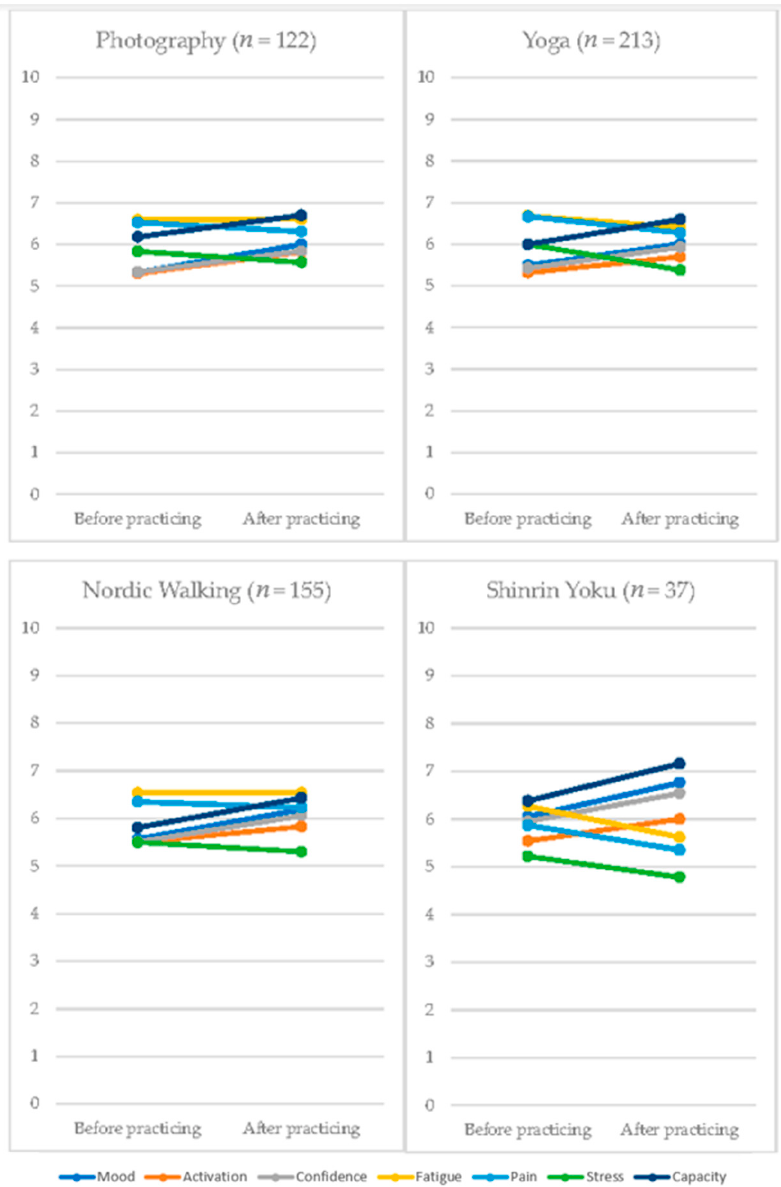
Figure 2. E ff ect of the di ff erent activities included in NAT-FM treatment: intra-session assessments Figure 2. Effect of the different activities included in NAT-FM treatment: intra-session assessments (EMA). Note: all p values < 0.05 except for fatigue in photography ( p = 0.92), and fatigue ( p = 0.95) and (EMA). Note: all p values < 0.05 except for fatigue in photography (p = 0.92), and fatigue (p = 0.95) pain ( p = 0.15) in Nordic walking. NAT-FM, nature activity therapy for